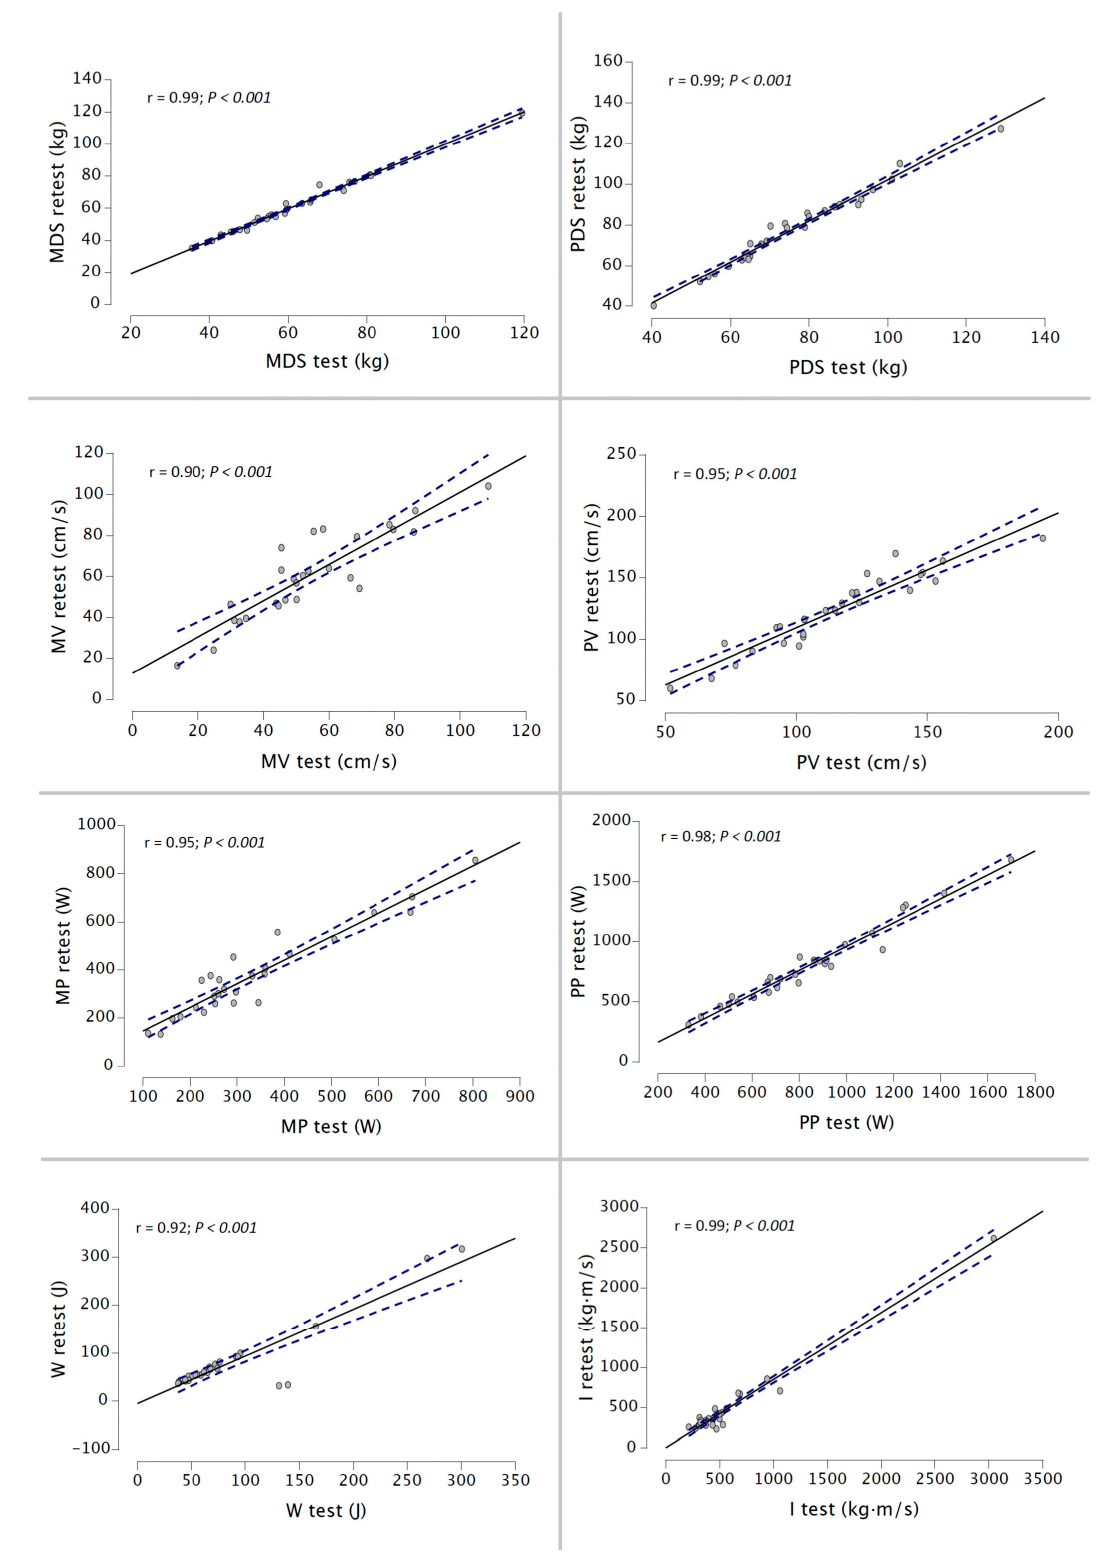
Figure 6. Relationship between MDS, PDS, MV, PV, MP, PP, W, and I between both testing sessions during 75% 1RM protocol using a DEMF.